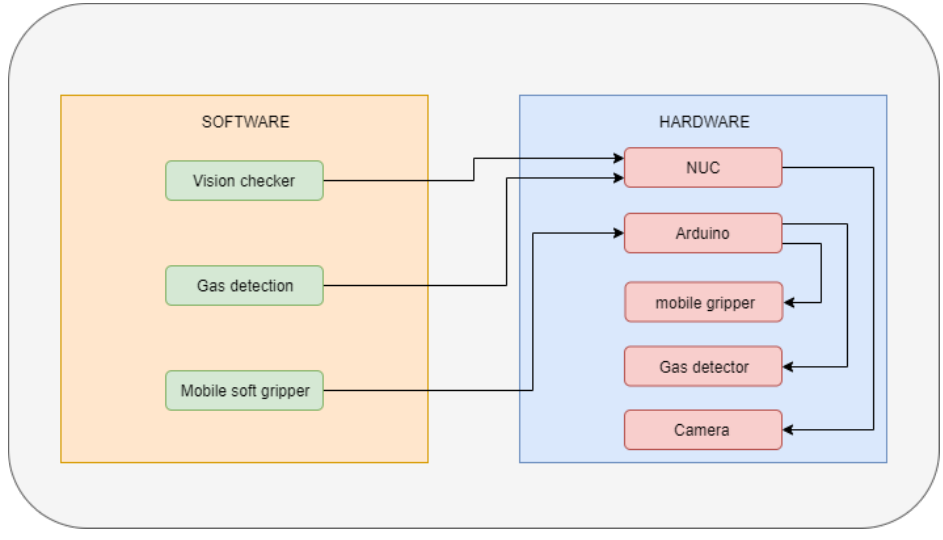
Figure 16. System scheme